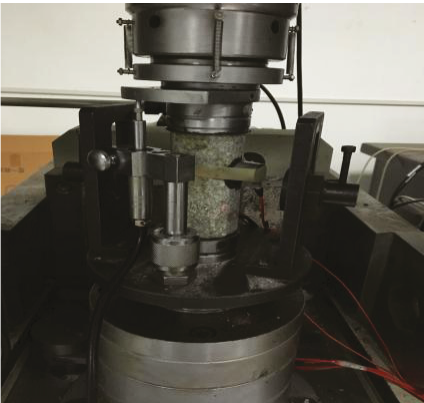
Figure 1: Uniaxial compression